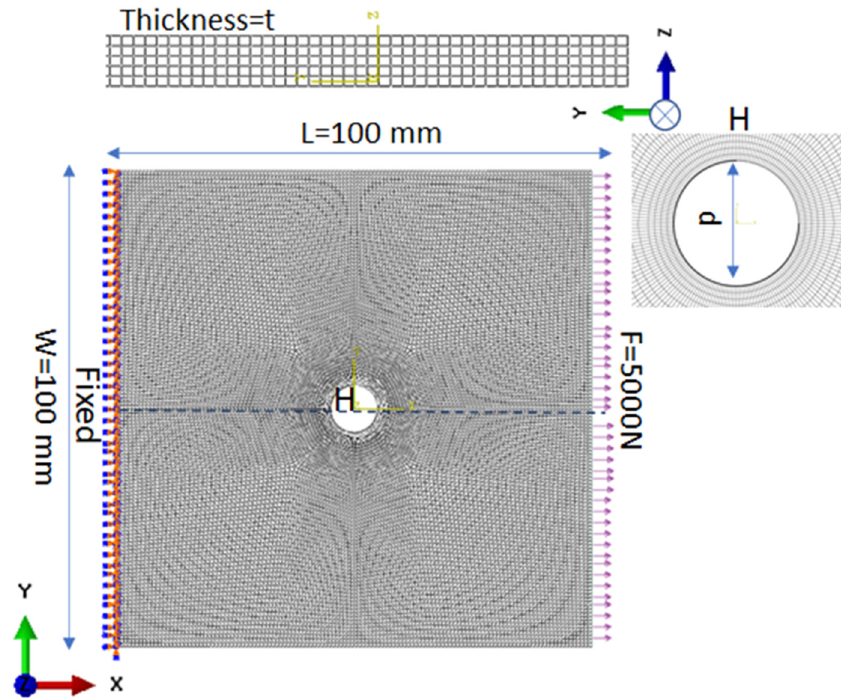
Figure 5. Finite element model of the macro plate.